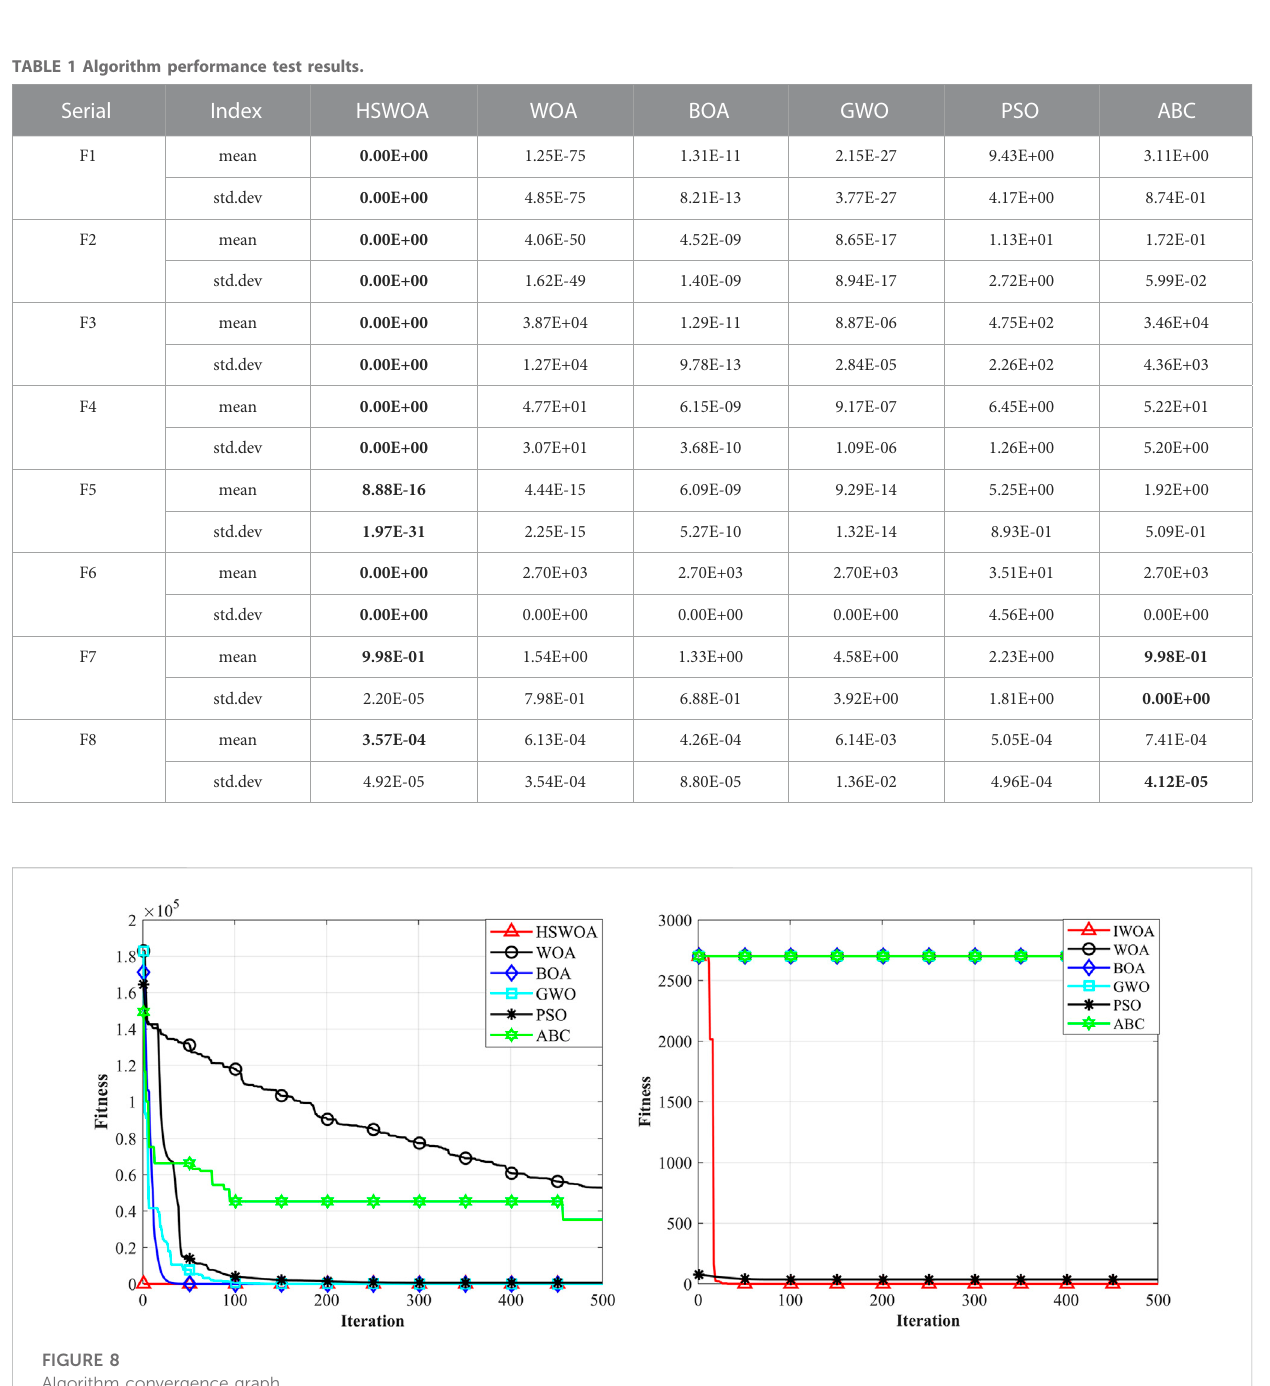
optimal solution thanks to the Sabol sequence, whereas the standard WOA converged more slowly than the other algorithms, indicating that the Sabol sequence for population initialization facilitates the rapid convergence of WOA to the global optimal solution. HSWOA ’ s overall optimization accuracy in the multi-peak benchmark test function was lower than that of the single-peak benchmark test function, and it only found the global optimal solution in F6. However, the convergence accuracy in all multi- peak benchmark test functions was higher than that of the other